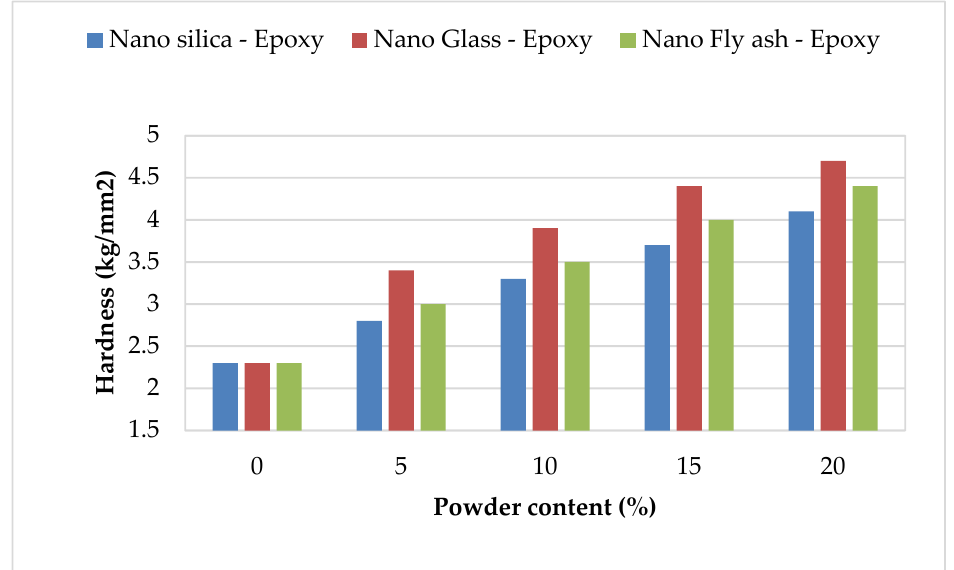
Figure 4. Hardness magnitudes of the nanopowder-filled epoxy.